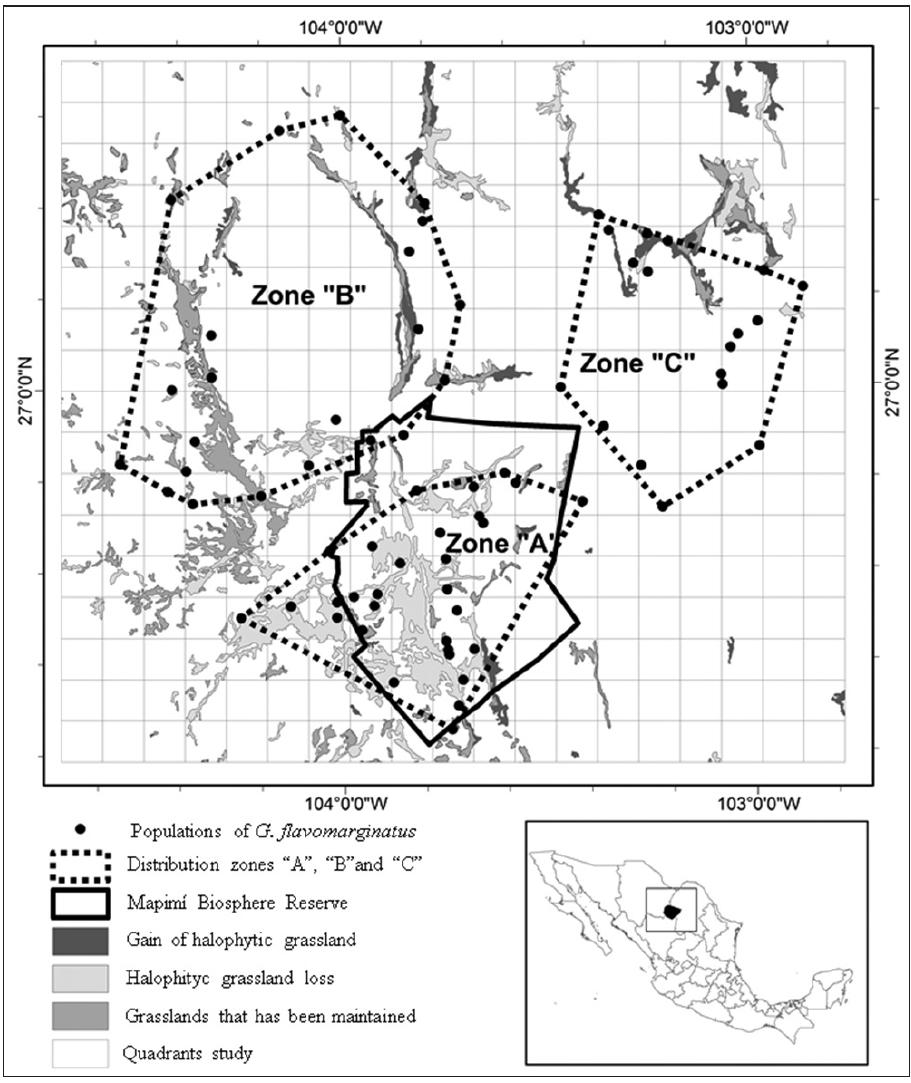
Figure 2. Distribution of gain and loss of the halophytic grassland in an area of 32,300 km 2 . Black spots show populations of G. flavomarginatus ; dotted lines show distribution zones “ A ”, “ B ” and “ C ” of the species; the black line indicates the Mapimí Biosphere Reserve; dark grey color shows the zones with gain of halophytic grassland; light grey color shows the zones of halophytic grassland loss; medium grey color shows areas with grasslands that has been maintained; the grid make reference to squares of 100 km 2 in the study